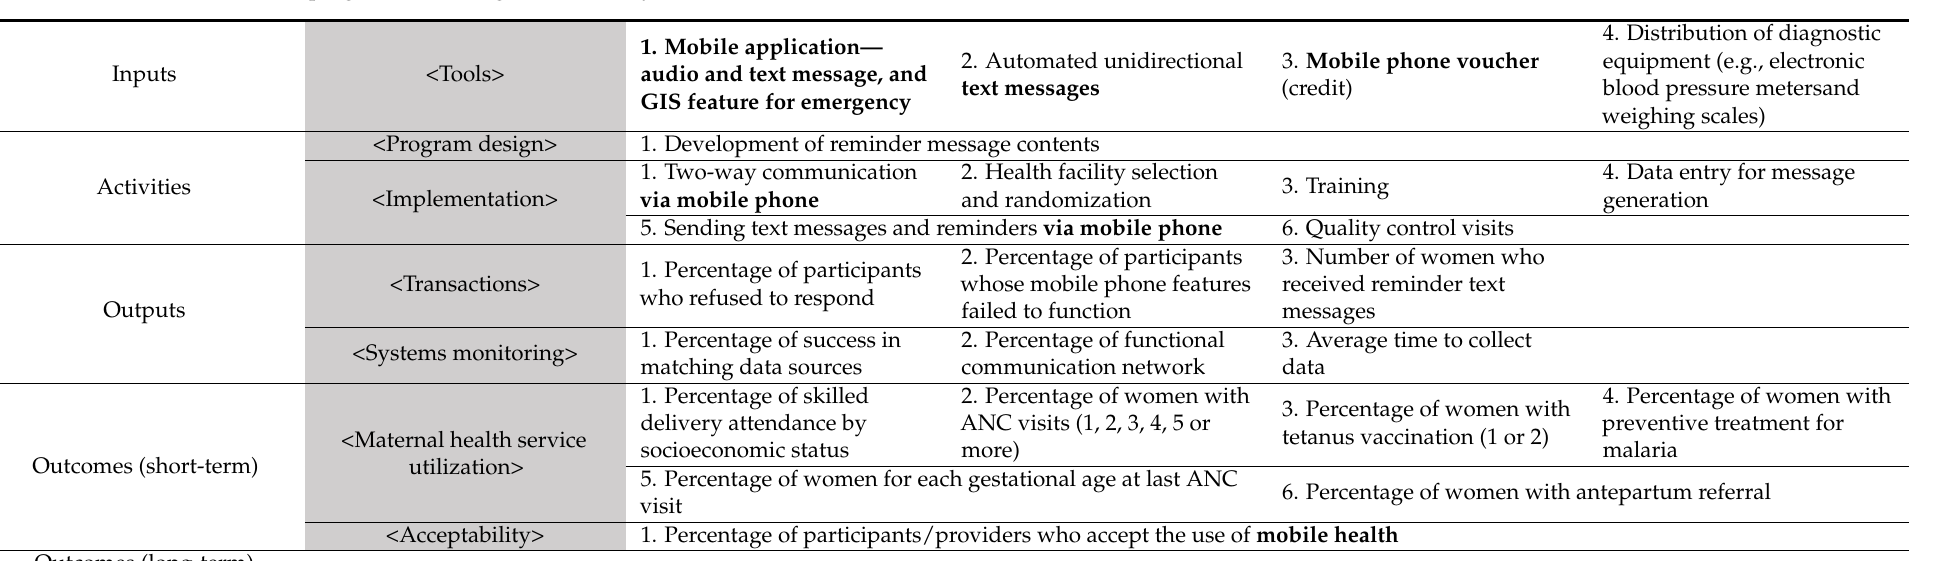
Table 5. Logic model for communication via maternal health e-voucher programs (enabled by mobile phone credit voucher programs or maternal e-voucher programs involving mobile